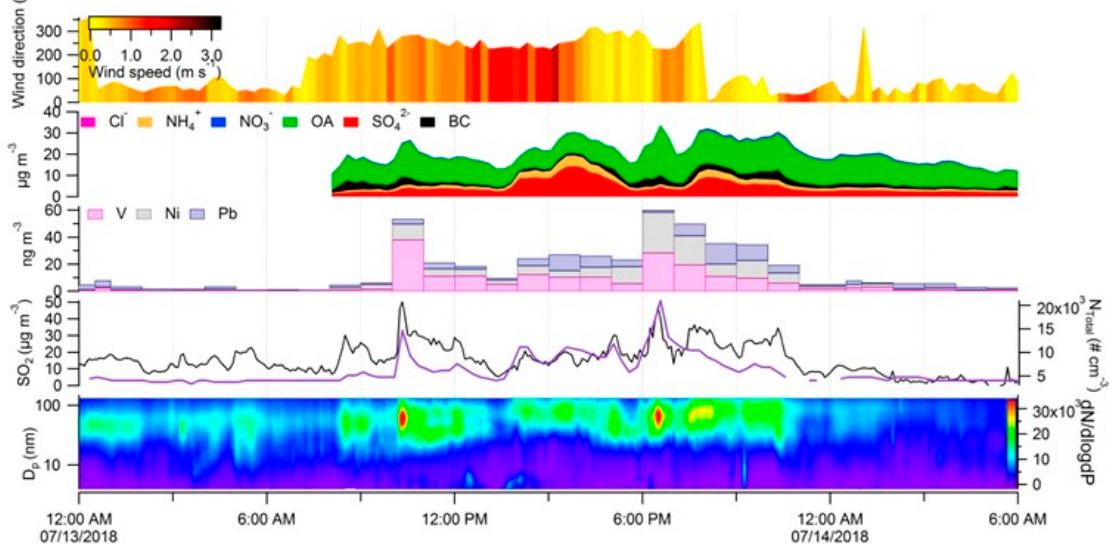
Figure 18. Time series of wind direction (color-coded by wind speed), Chemical species of PM 1 (OA, SO 42 − , NH 4+ , NO 3 − , Cl − , and BC), metals (V, Ni, and Pb), SO 2 , total particle number and size distribution measured with a nanoSMPS (3–158 nm) during 13 July 2018, in Marseille.